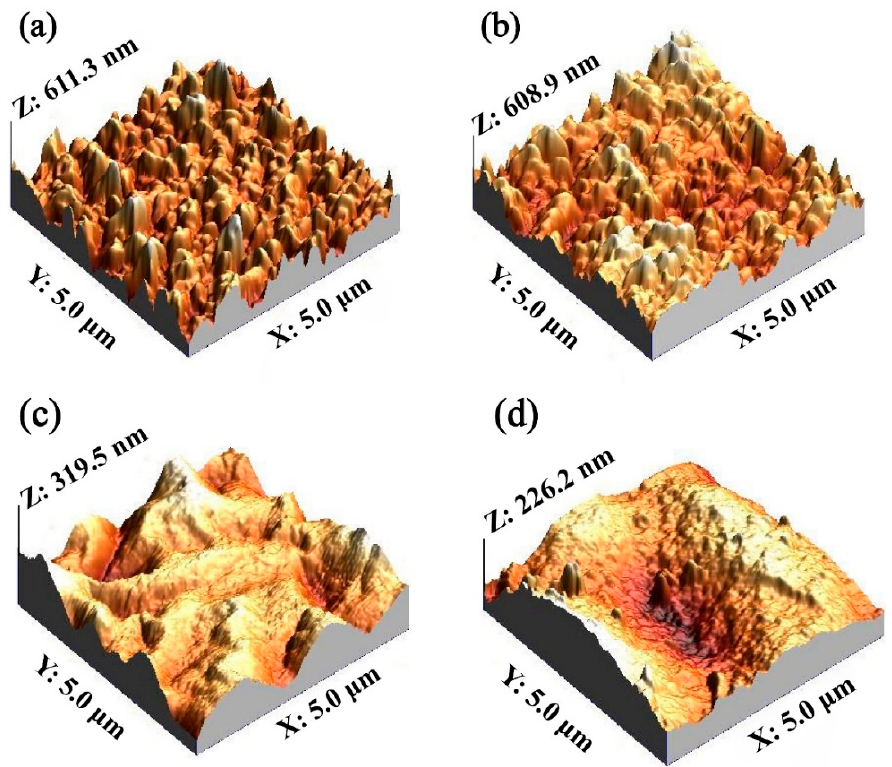
Figure 3. Surface roughness: ( a ) PES membrane without a PA layer, ( b ) Car-PES membrane without a PA layer, ( c ) PES membrane with a PA layer and ( d ) Car-PES membrane with a PA layer.